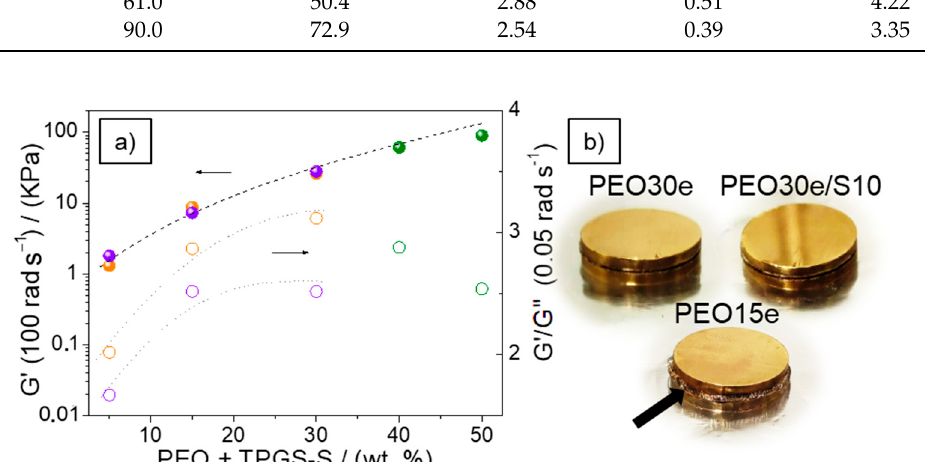
(cid:4594) at 0.05 rad s − 1 at 0.05 rad G (cid:48)(cid:48) (cid:2891) (cid:4594)(cid:4594)